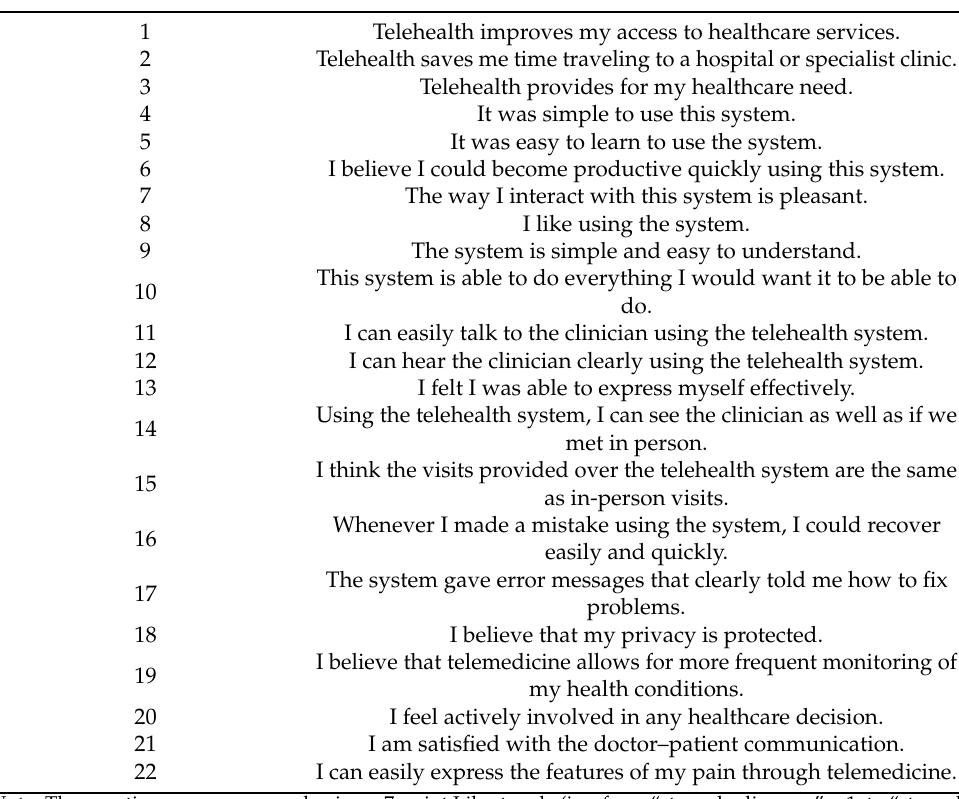
Table 2. The adopted 22-item